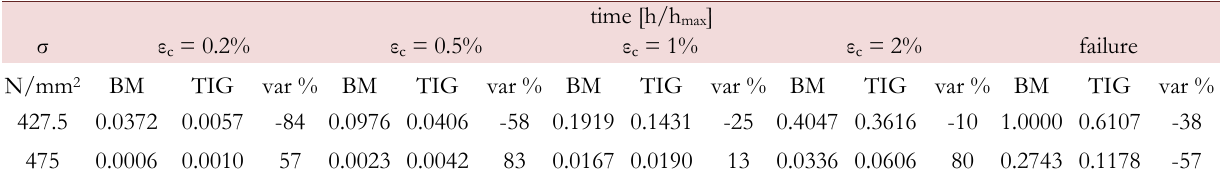
Table 7: Creep behaviour of base material and